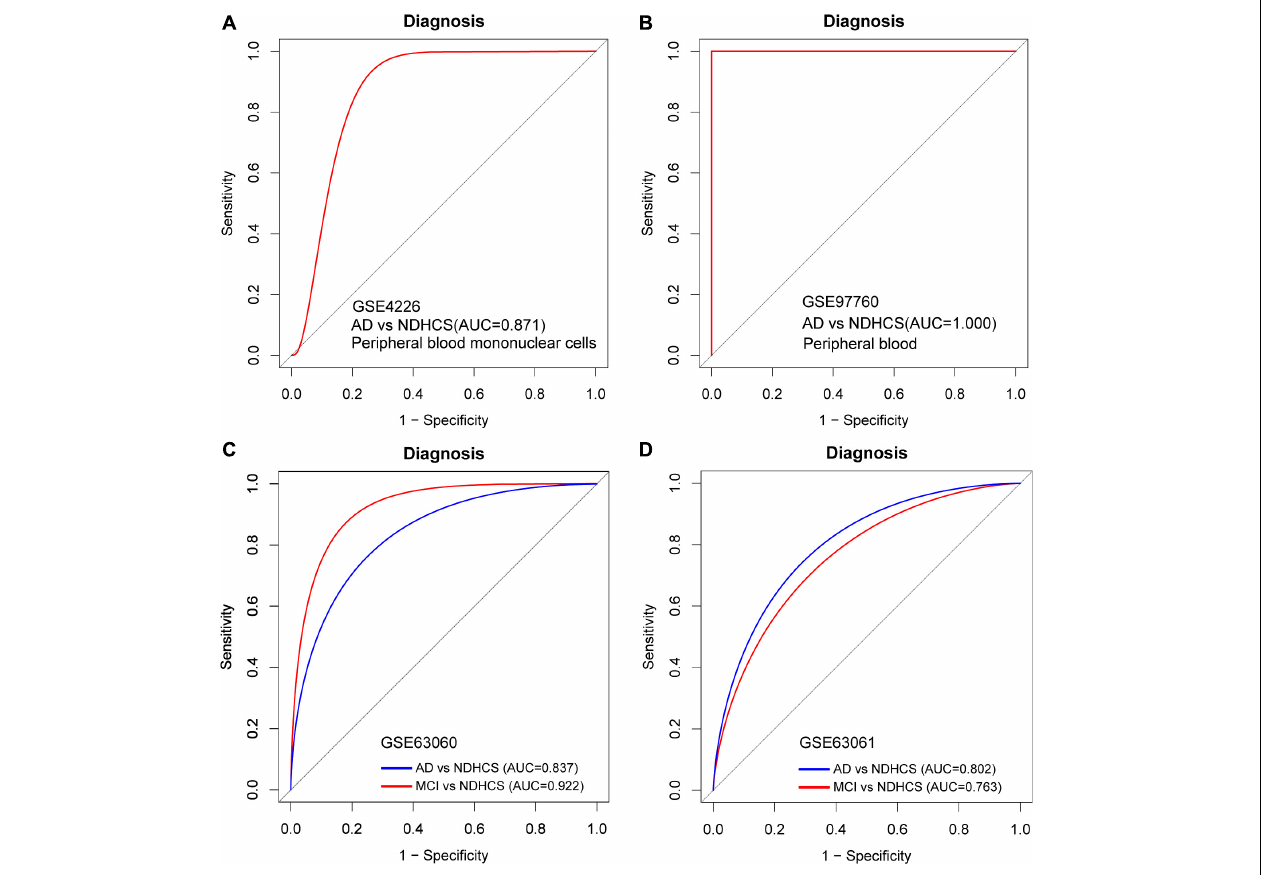
FIGURE 7 | ROC curve analysis in blood datasets. (A) ROC curves of peripheral blood mononuclear cell data from GSE4226. (B) ROC curves of peripheral blood data from GSE97760. (C) ROC curve analysis of GSE63060. (D) ROC curve analysis of GSE63061. AD, Alzheimer’s disease; MCI, mild cognitive impairment; NDHCS, non-demented healthy control subjects; AUC, area under the